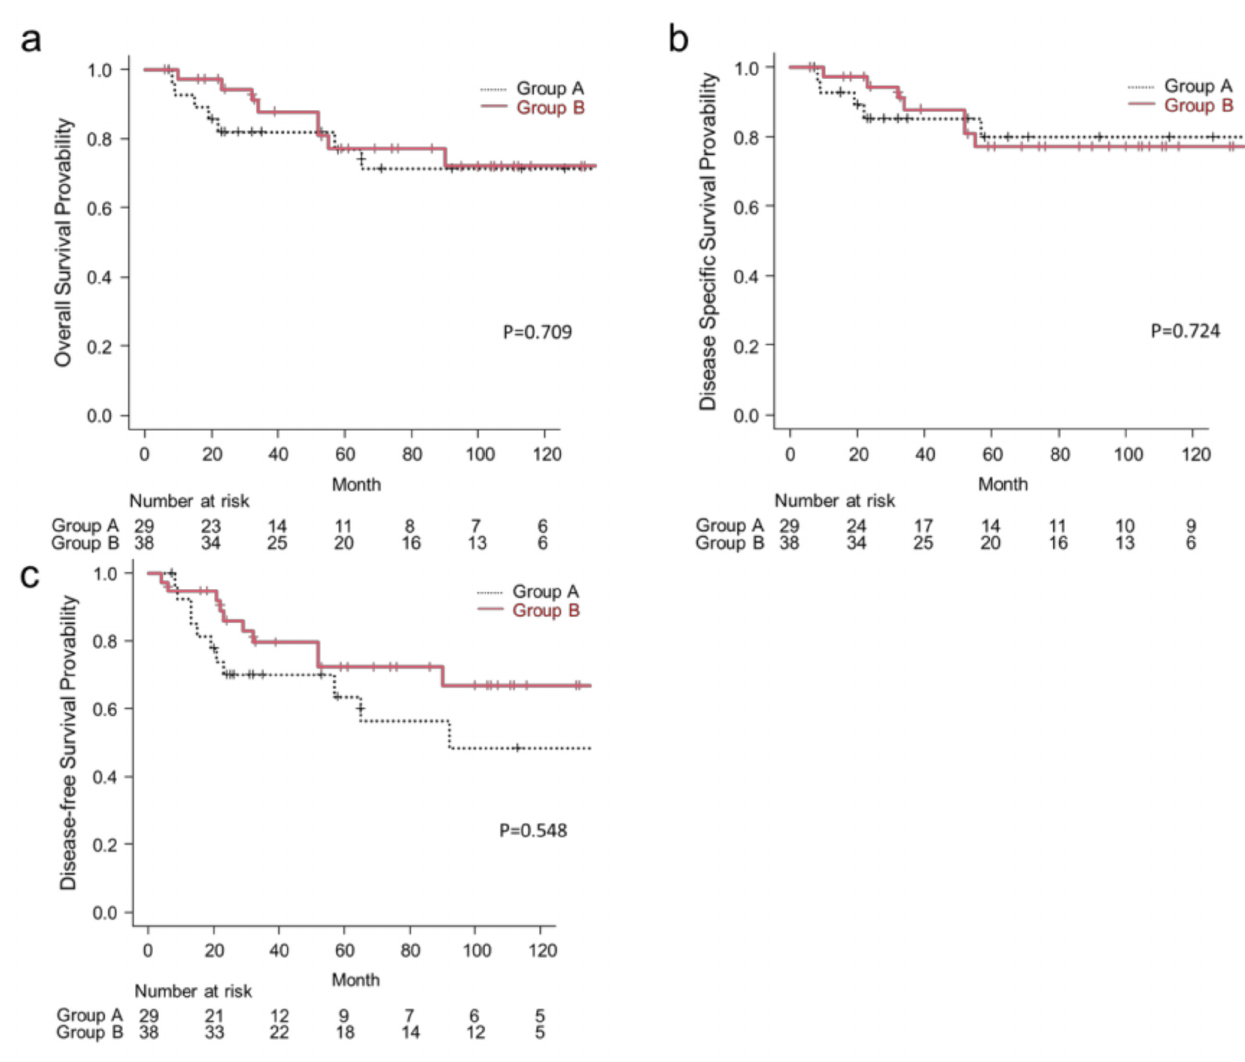
Figure 1. Kaplan–Meier curves of Group A and Group B (( a ) OS; ( b ) DSS; ( c ) DFS). OS, overall survival; DSS, disease-specific survival; DFS, disease-free